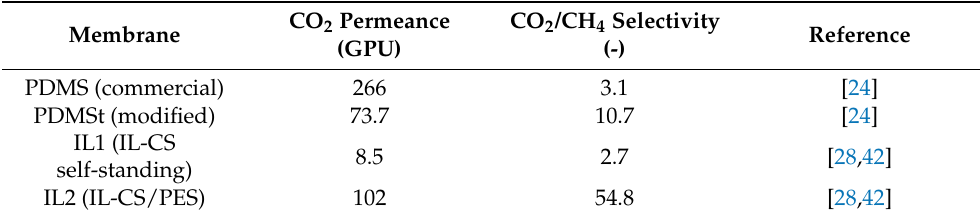
Table 1. Characterization in terms of permeance and selectivity of the selected membranes for the CO 2 /CH 4 separation process. Test type: single gas experiments, laboratory cell, pressure = 2 atm, temperature = 298